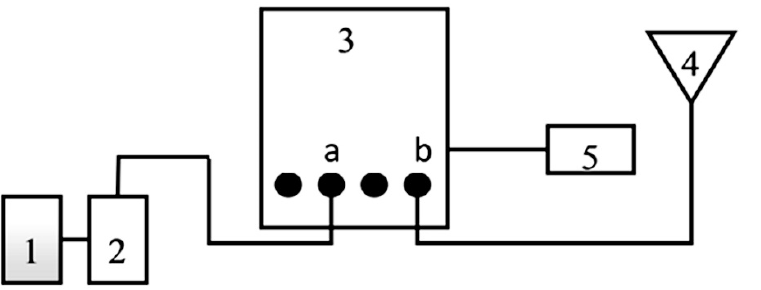
Figure 2. Scheme of apparatus for collecting atmospheric air samples into a liquid absorption me-